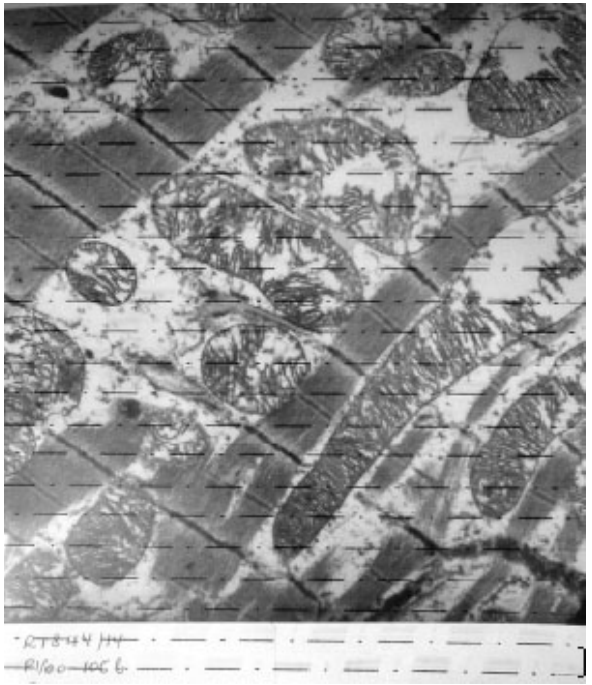
Fig. 1 - Imagem de uma micrografia eletrônica de um fragmento de miocárdio obtido do ápice do ventrículo esquerdo com aumento de 23.100 vezes, com a aplicação do sistema teste